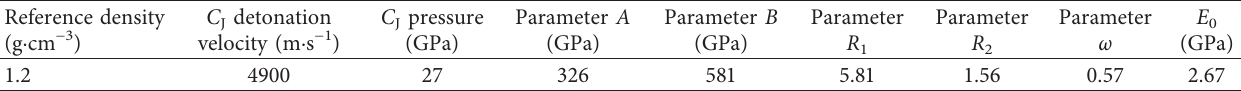
Table 1: Explosive parameters.